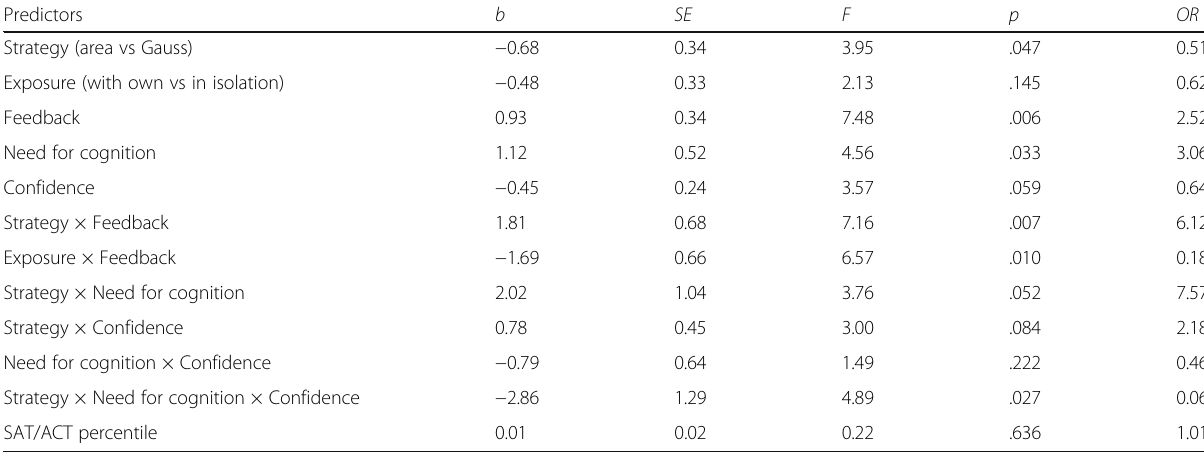
Table 2 Predictors of adoption of target strategy for Study 2 Predictors b SE F Strategy (area vs Gauss) − 0.68 Exposure (with own vs in isolation) − 0.48 Feedback Need for cognition Confidence − 0.45 Strategy × Feedback Exposure ×